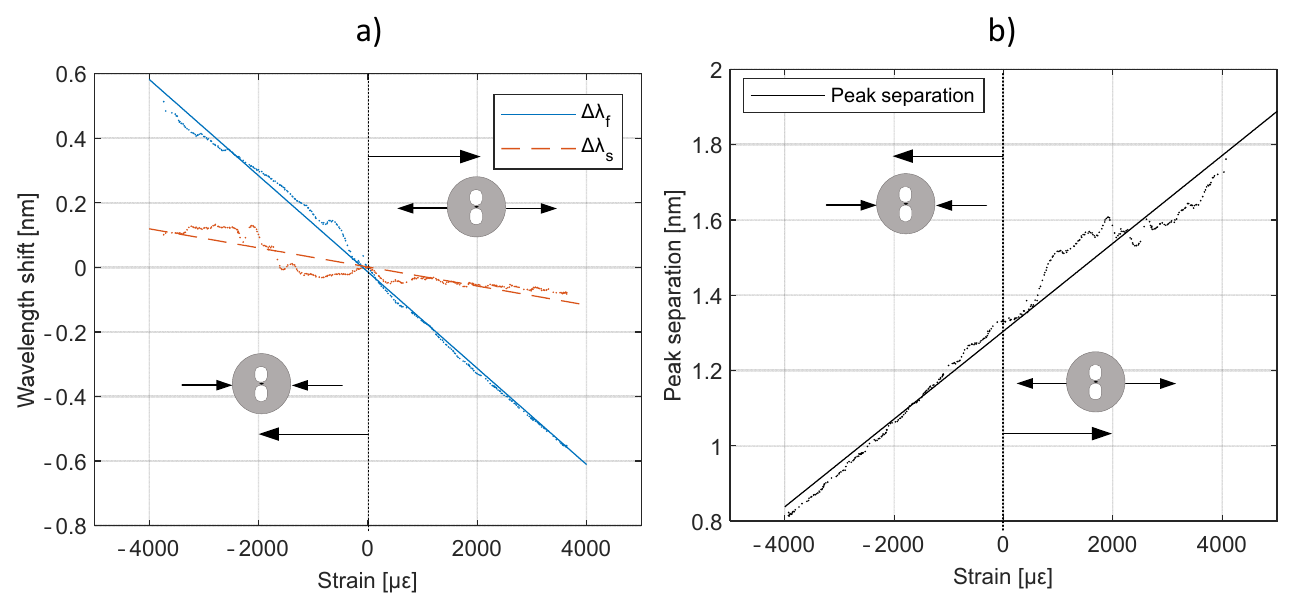
Figure 11. Bragg grating response for transversely applied strain: ( a ) shift and ( b ) separation of Bragg wavelengths.